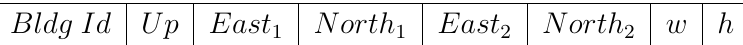
Table 1. Building model parameters.